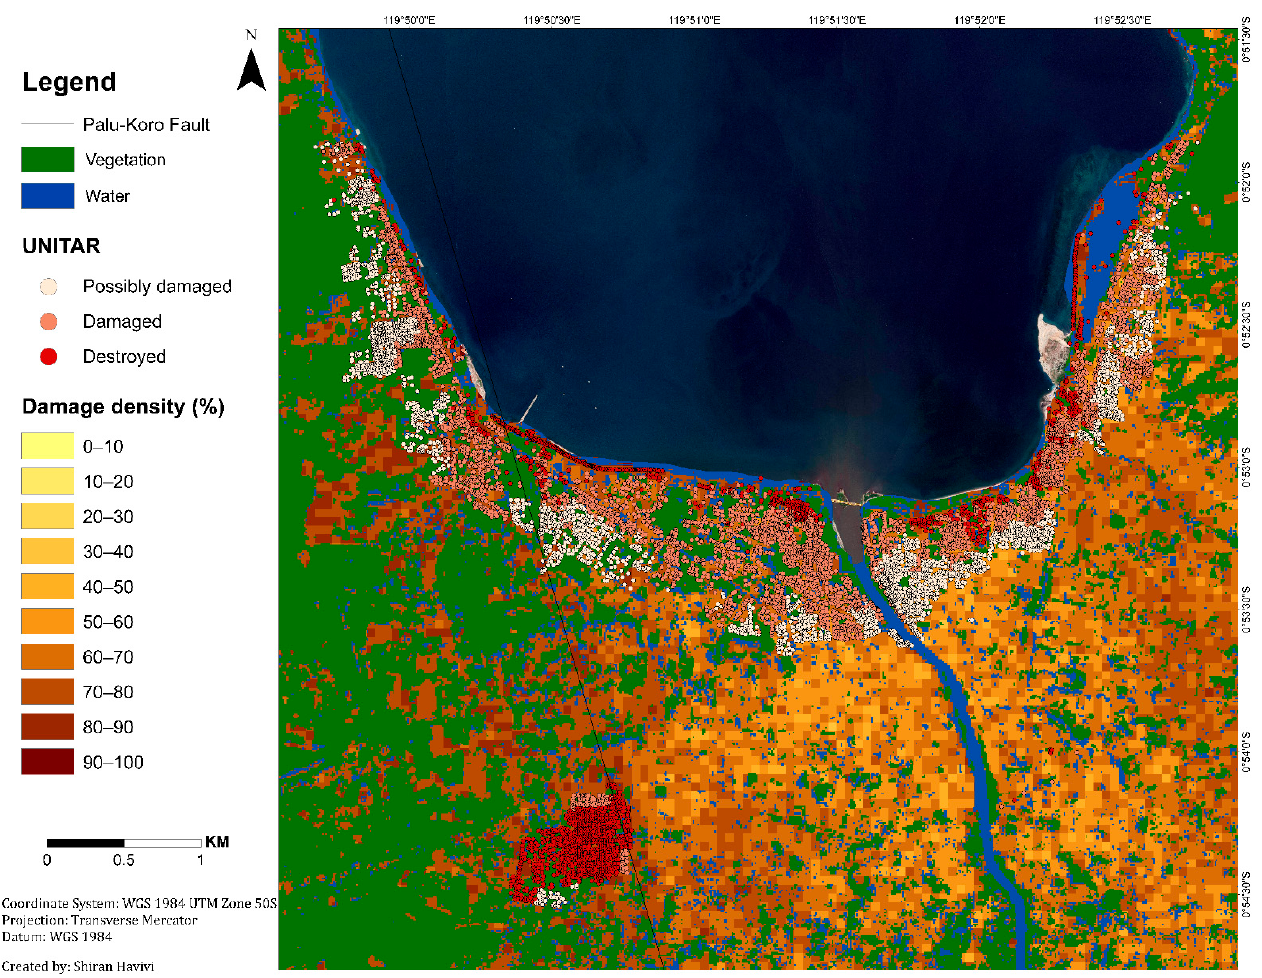
Figure 10. Damage assessment map vs. UNITAR database.